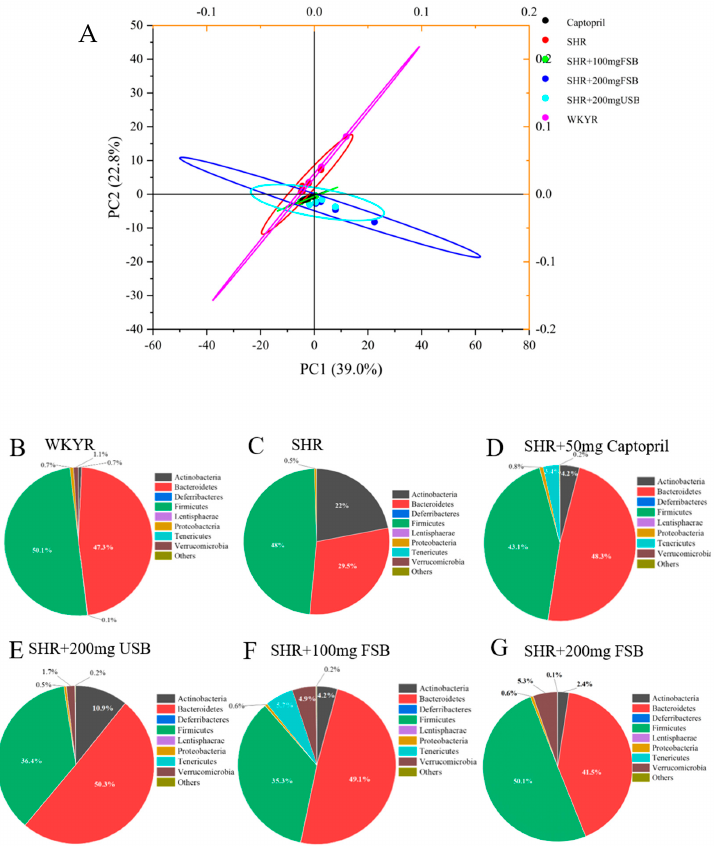
Figure 4. FSB and USB feeding modulates the gut microbiota of SHR at the genus level. ( A ). PCoA analysis of the experimental animals is shown along the first two principal coordinate axes. Differ- ent coloured dots indicate the animals in each experimental group. Pie charts show the gut microbial phyla in ( B ). WKYR, ( C ). SHR, ( D ). SHR + 50 mg Captopril, ( E ). SHR + 200 mg USB, ( F ). SHR + 100 mg FSB ( G ). SHR + 200 mg FSB. Different pies represent different genera and their sizes represent their relative abundance in the stools of experimental rats. Meanwhile, consumption of FSB and USB improved microbial diversity and even- ness by boosting the growth of Verrucomicrobia and Tenericutes (which were initially un- detected) as well as Bacteriodetes (from 29.5% to over 40%) while reducing the levels of overrepresented groups (Figure 4B–G). Relative to USB, FSB significantly boosted the populations of Verrucomicrobia and reduced Actinobacteria in the gut. At the genus level, 14 genera significantly abundant in WKYR were diminished in SHR (Figure 5). Interest- ingly, feeding SHR with 100 mg/kg FSB significantly boosted the levels of 7 (50%) of those genera namely Akkermansia , Bacteroides , Intestinimonas , Phocaeicola , Kineothrix , Prevotella and Longibaculum , while 200 mg/kg FSB boosted the levels of 8 (almost 60%) genera ( Ak- kermansia , Phcaeicola , Intestinimonas , Bacteroides , Prevotella , Longibaculum , Lactobacillus and